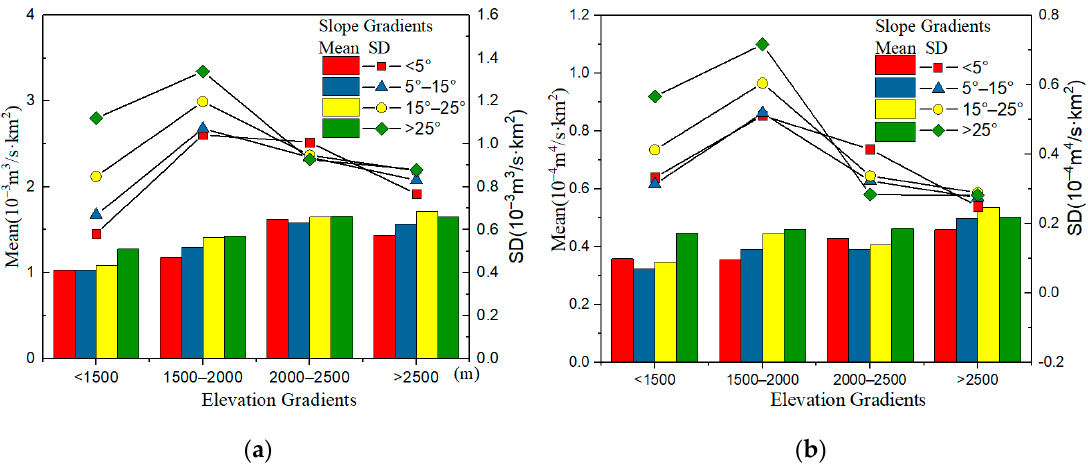
Figure 6. Variation of runoff modulus ( a ) and runoff erosion power ( b ) on different terrain gradient based on HRUs.